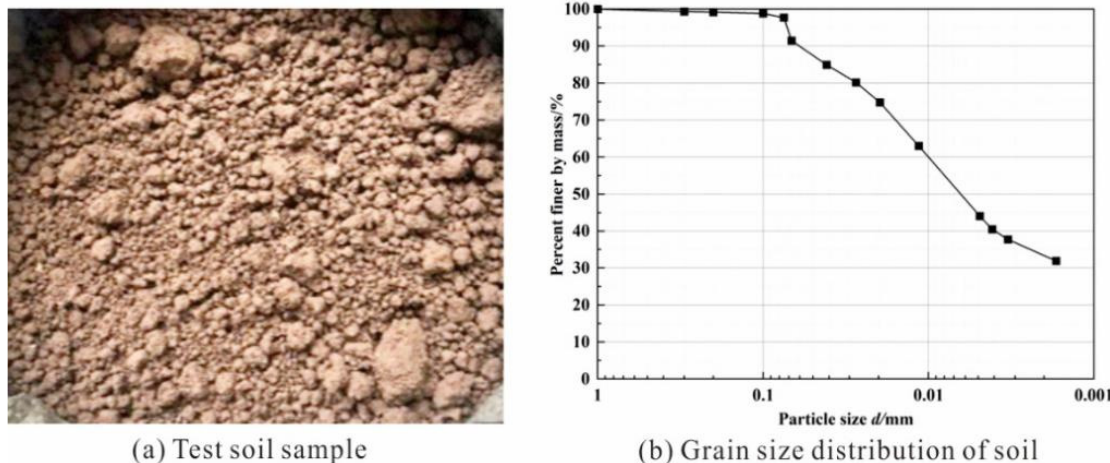
Figure 1. ( a ) Test soil sample; ( b ) grain size distribution of soil.